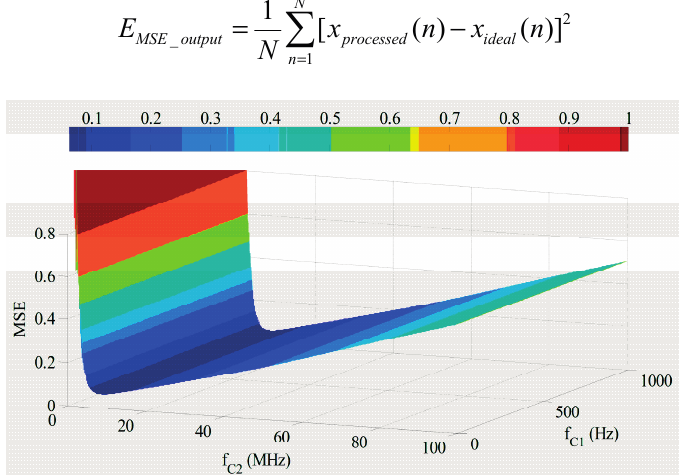
Figure 2. Variation of the MSE with f C1 and f C2